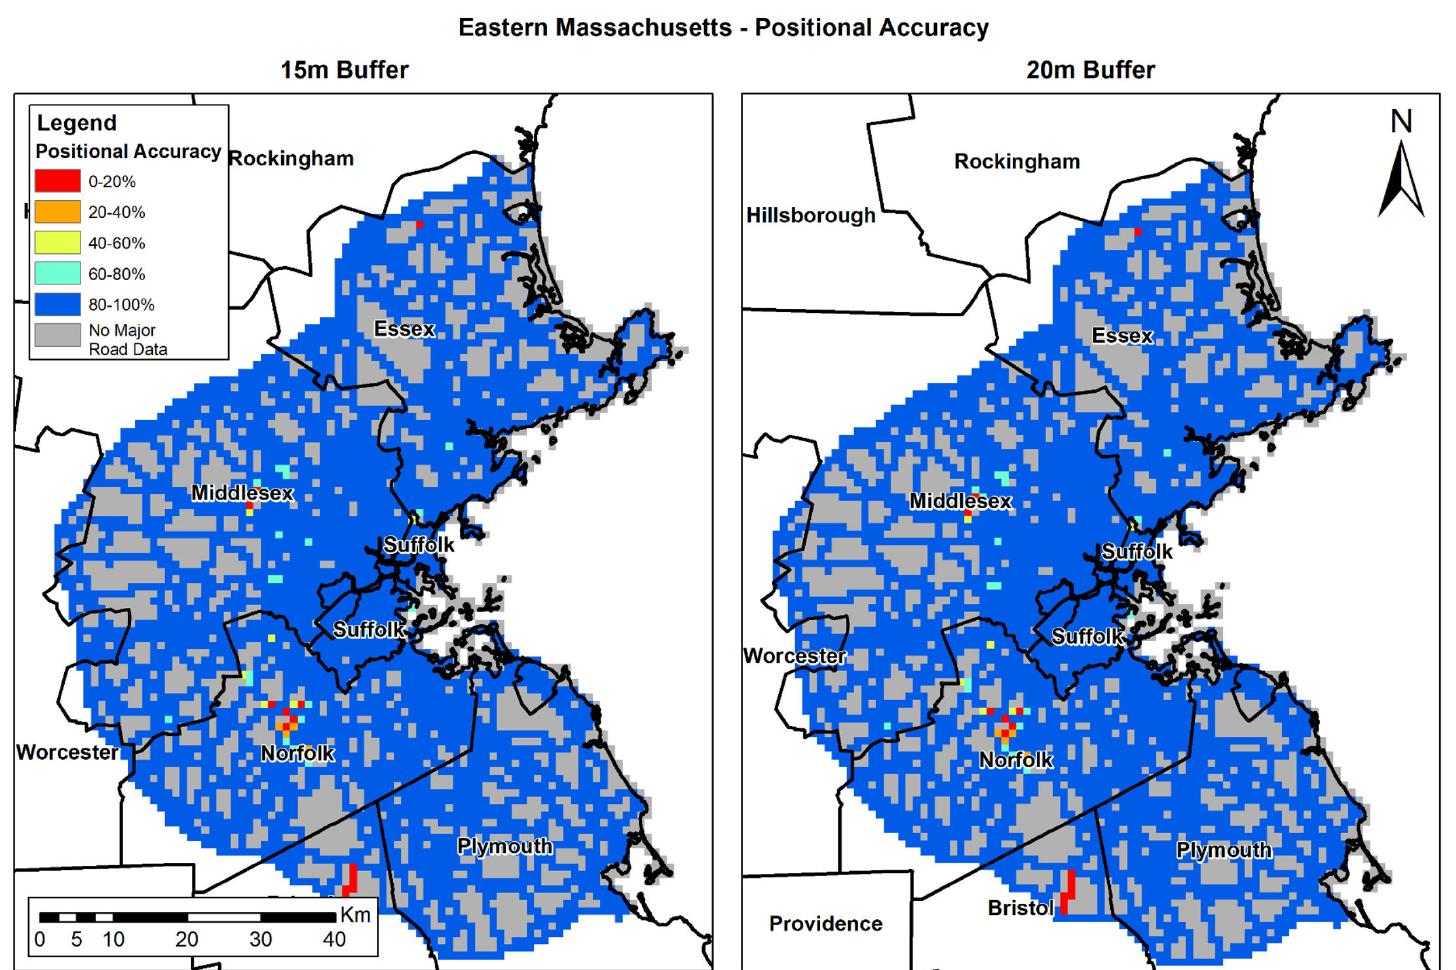
Figure 5. Eastern Massachusetts’ PA (%): 15 m ( left ) and 20 m ( right )